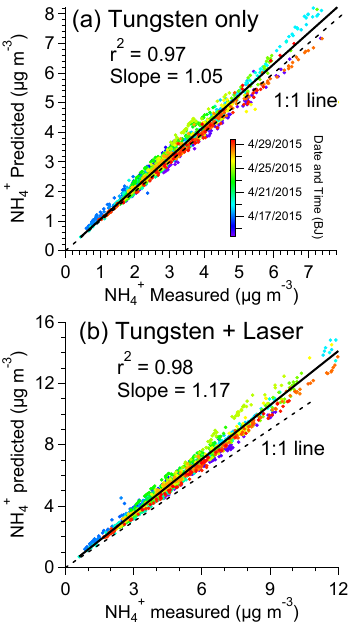
Figure 3. Scatter plots of the predicted NH + concentrations (colored by time), in the case of (a) Tungsten va- porizer only, and (b) dual vaporizers (Tungsten + laser). The pre- dicted values were calculated according to the formula: NH + dicted = 18 × (2 × SO 2 −